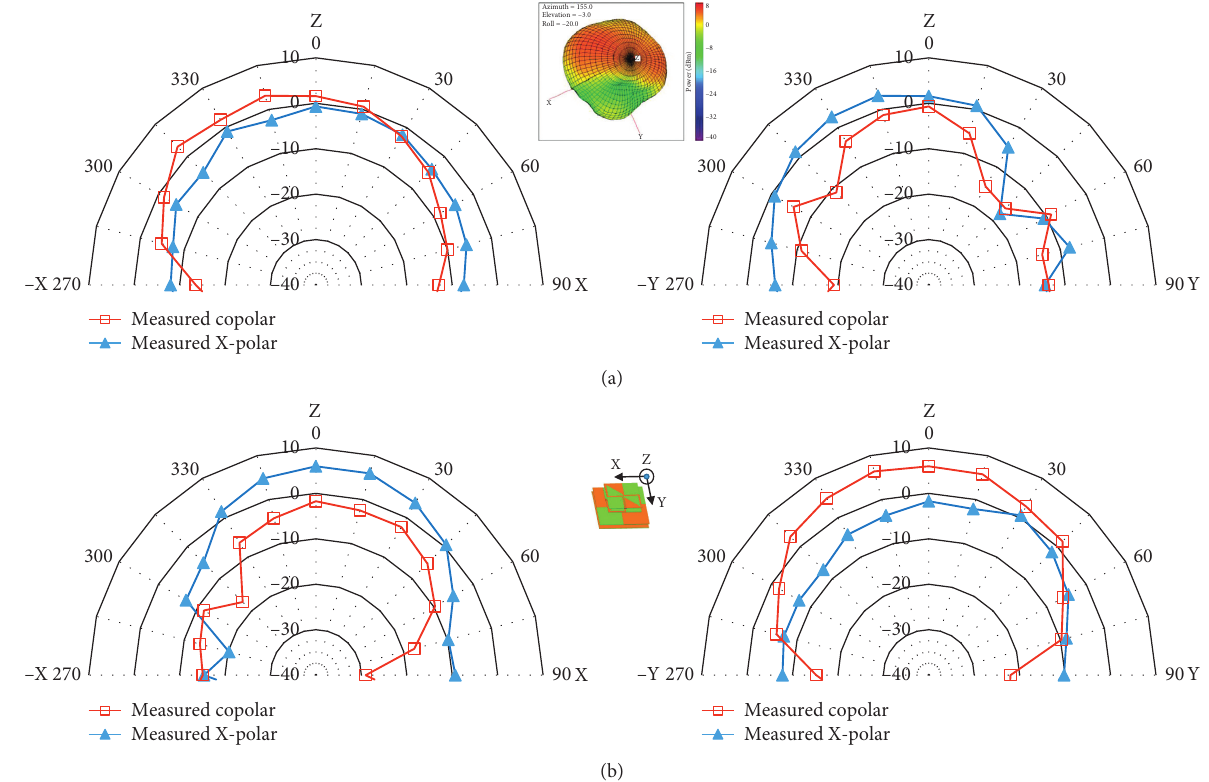
Figure 11: Measured radiation patterns when feeding on xz-plane and yz-plane at 2.4GHz: (a) port-1 and (b) port-2.